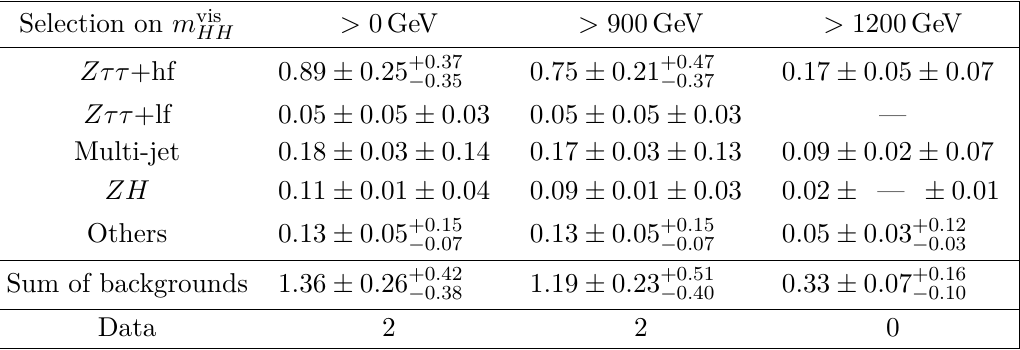
Table 3. Event yields of the various estimated backgrounds and data, computed in the SR of the search for X → HH → b ¯ bτ + τ − . The background labelled as ‘Others’ contains W +jets, diboson, t ¯ t and single-top-quark events. Statistical and systematic uncertainties are quoted, in that order. The background yields and uncertainties are pre-fit and are found to be similar to those post-fit. A dash ‘—’ indicates a yield or uncertainty below